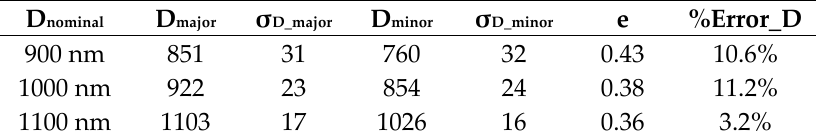
Table 1. The statistical distribution of the variations in the shape of the metamaterials fabricated using UV lithography. D1 and D2 are the minor and major axis of the disks, σ Di is the standard deviations, and e is the calculated eccentricity of the